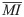
Correlation between the non-normalized values of MI¯ and average domain pair entropies.Number of domain pairs (data points) N = 5, 205. The value of the Pearson correlation coefficient r ≈ 0.464; the value of the Spearman’s rank correlation coefficient ρ ≈ 0.460.